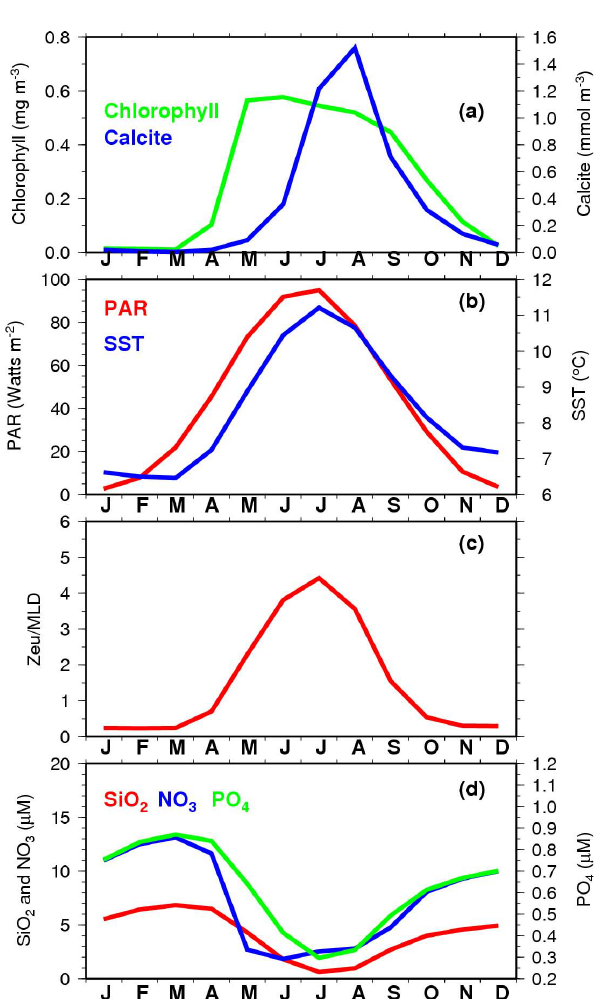
Fig. 12. Seasonal cycles of Chl a and calcite (a) , PAR and SST (b) , Zeu:MLD ratio (c) , and nutrients (d)